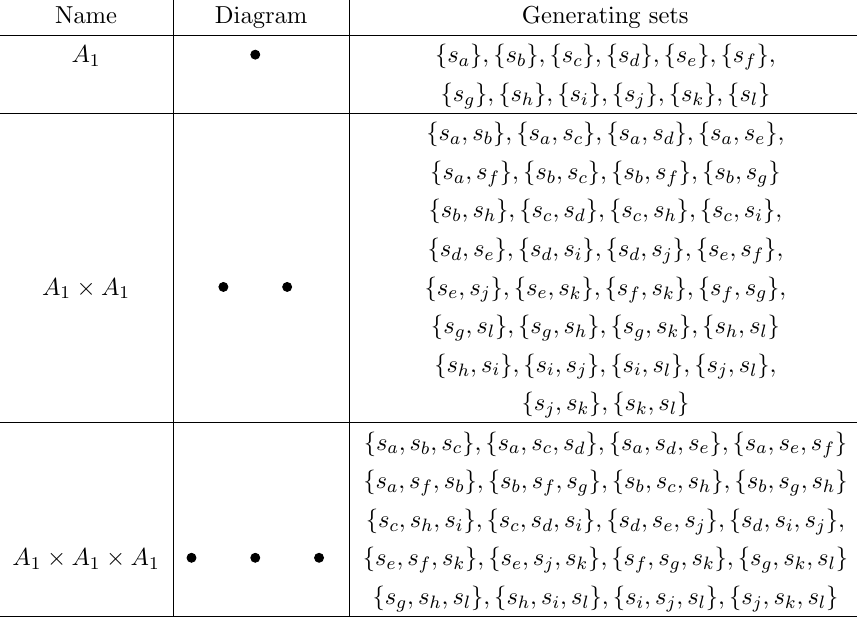
Table 3 . Elliptic subdiagrams of (cid:6)( P 2